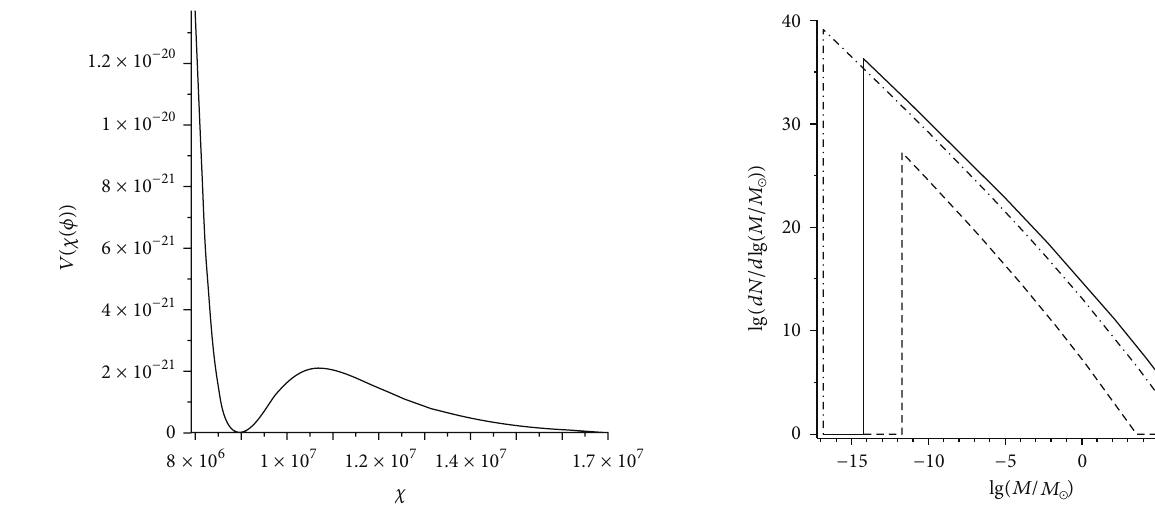
Figure 2: Potential possesses one maximum at 𝜒 = 𝜒 minimum at 𝜒 = 𝜒 min . When the field in some region reaches the some part of causally independent domains can flip value 𝜒 = 𝜒 crit to the other side of the potential with the field value 𝜒 > 𝜒